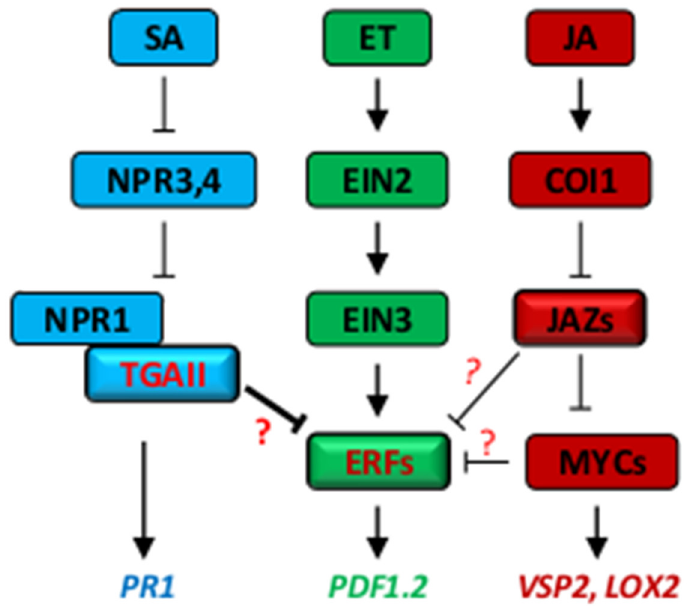
Figure 4. A simplified schematic representation of the signaling network between defense hormones, highlighting the crosstalk at the transcriptional level. Arrows indicate positive effects (activation), blunt-ended lines indicate negative effects (repression), questions indicate unknown mechanisms underlying the repression of ERFs by TGAs, JAZs and MYCs.